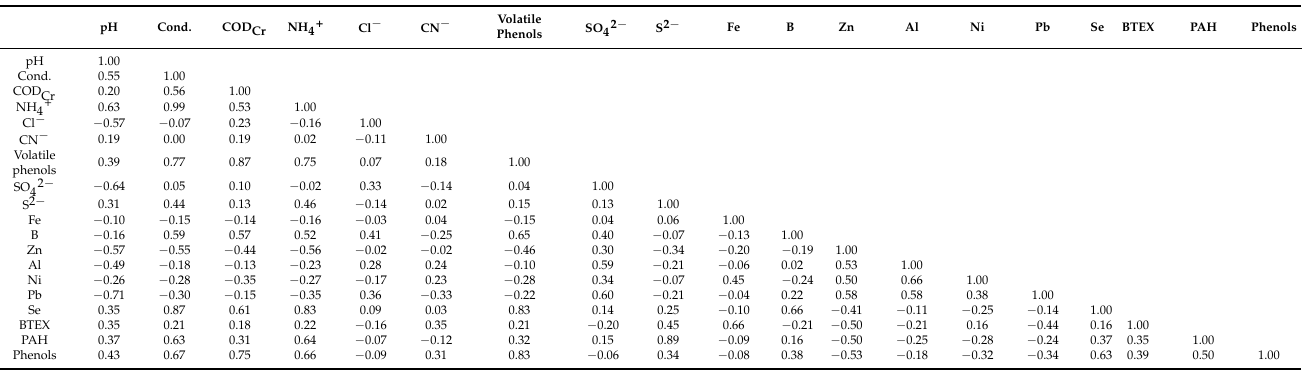
Table 5. Pearson correlation matrix—results of the linear correlation analysis of physicochemical parameters of UCG